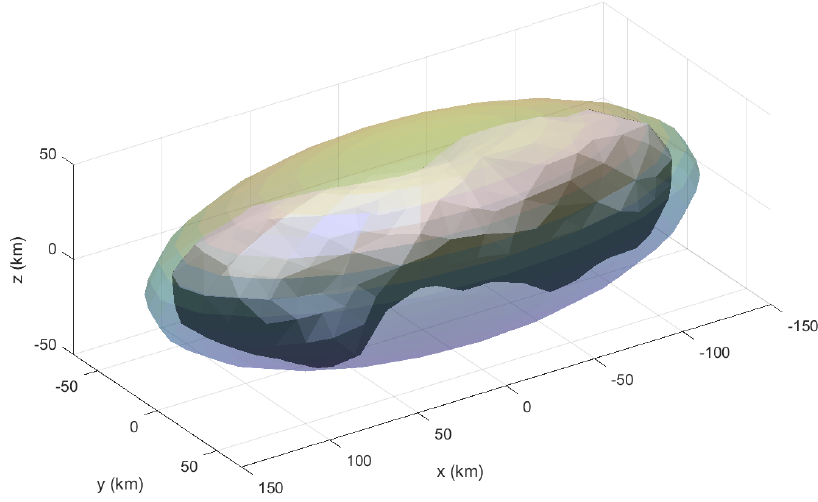
Figure 4. Safety ellipsoid.